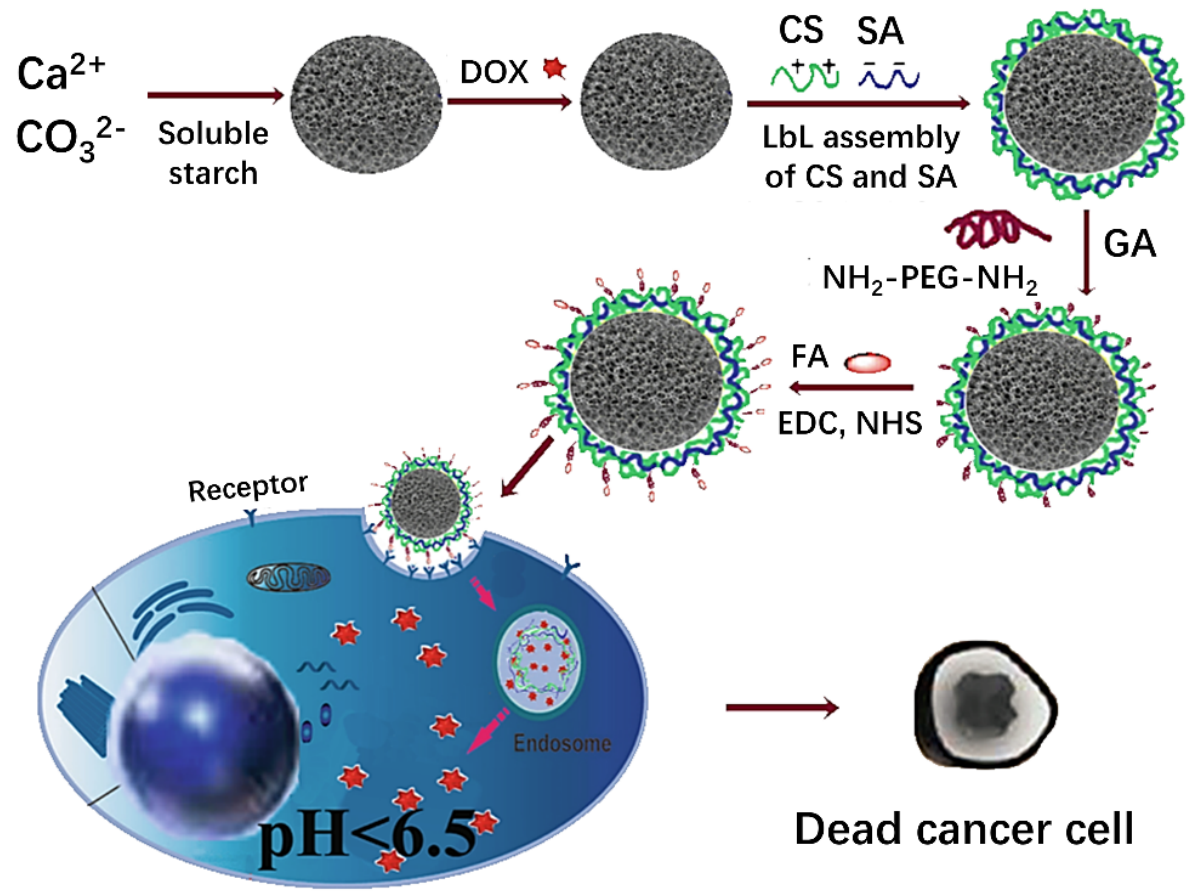
Figure 6. Coated CaCO 3 nanoparticles were prepared using the LbL method for the targeted delivery and controlled release of drug molecules. Reproduced with permission from [115], Hindawi (open access), 2020. (DOX: doxorubicin; CS: chitosan; SA: sodium alginate; FA: folic acid; GA: glutaraldehyde; PEG: poly(ethylene glycol); EDC: N-(3-dimethylaminopropyl)-N ′ -ethylcarbodiimide; NHS: N-hydroxysuccinimide).